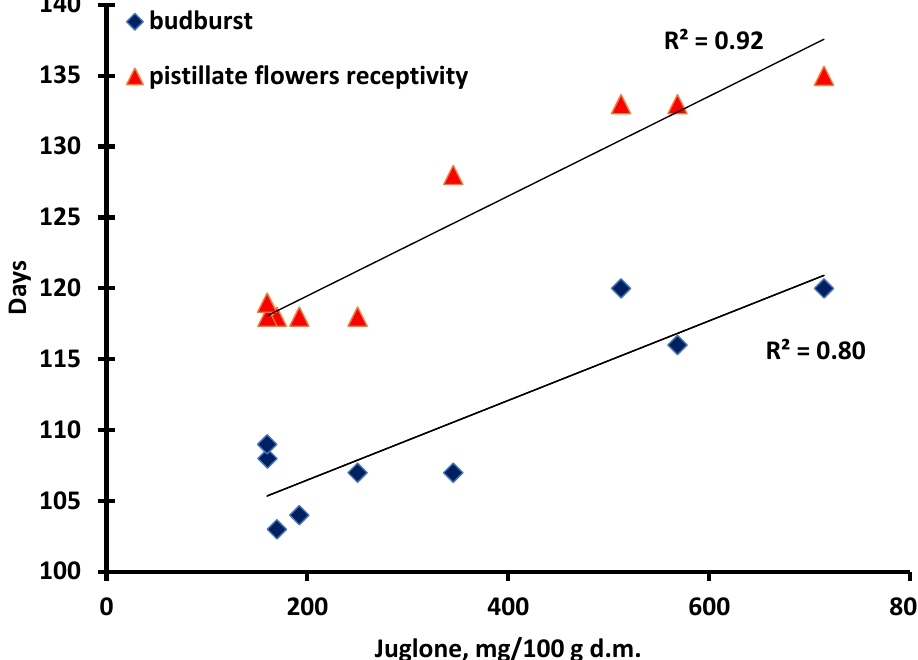
Figure 4. Correlation between the budburst and pistillate flowers’ receptivity and the concentration of juglone.